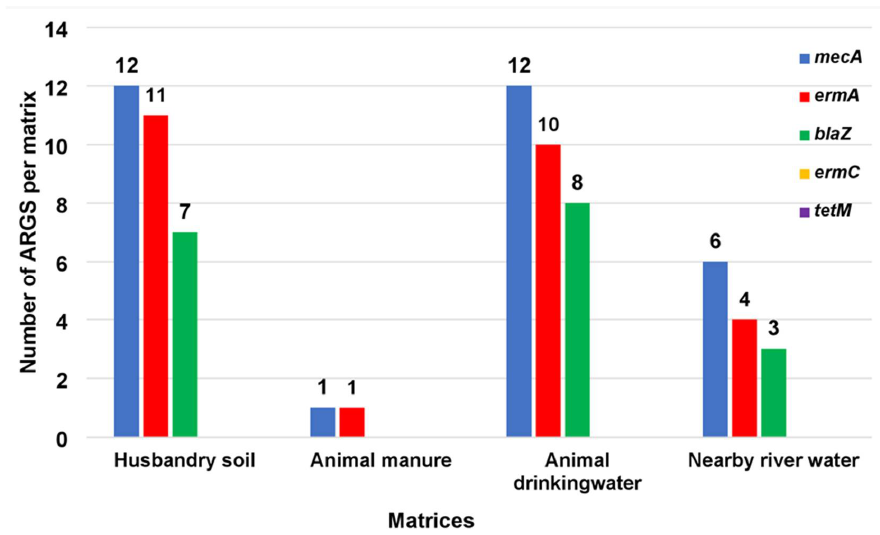
Figure 2. The distribution of five selected ARGs assessed in isolated MRSA from sampled matrices.